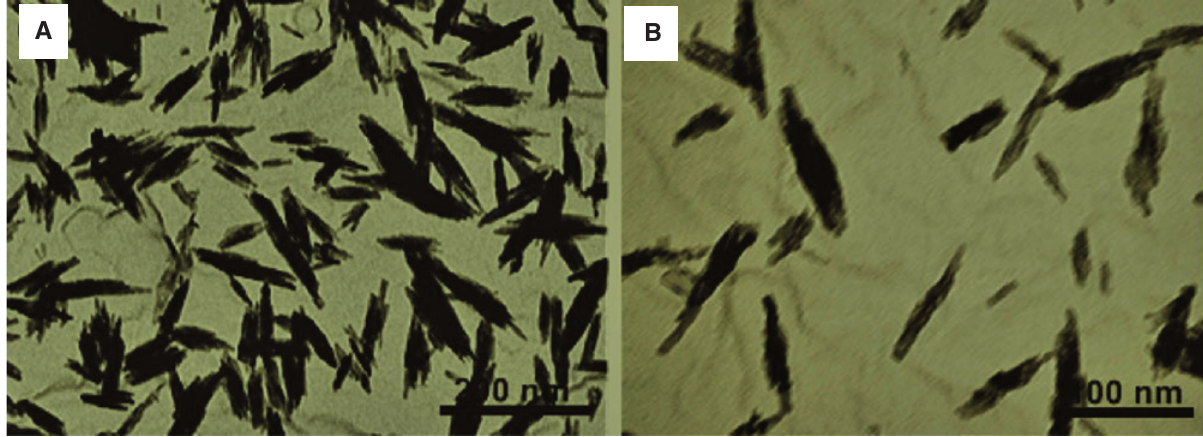
Figure 1: TEM images of as-prepared phase-pure hydroxyapatite nanorods prepared by using method 1 based on calcium nitrate and diam- monium hydrogen phosphate precursors (A) bar = 200 nm, and (B) bar = 100 nm, via co-precipitation